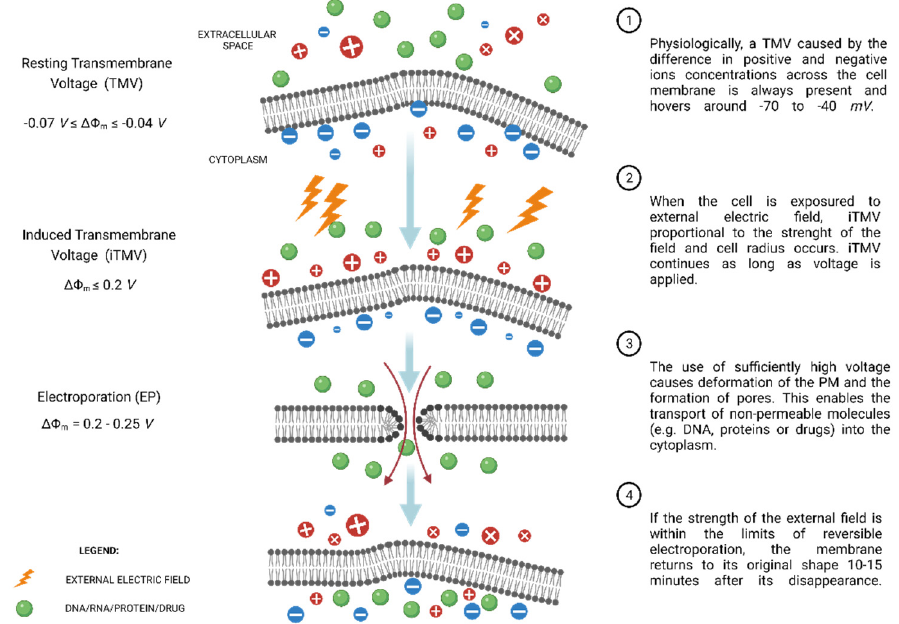
Figure 2. Conceptual scheme of electroporation/electrochemotherapy mechanism [14,39,40]. There are two types of EP, depending on pulse duration, electric field intensity, and cell features (e.g., size, membrane curvature) [25]. Aguilar et al. refer to a “two-threshold